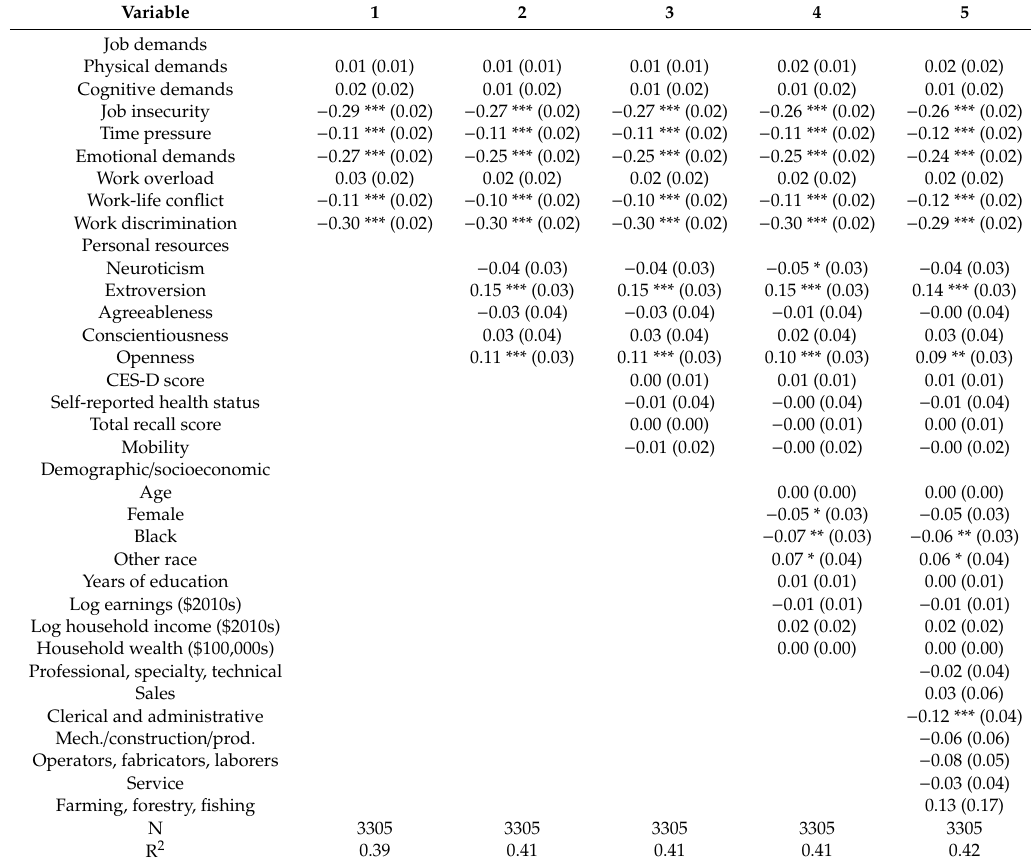
Table 4. Regression analysis predicting subjective HRS job